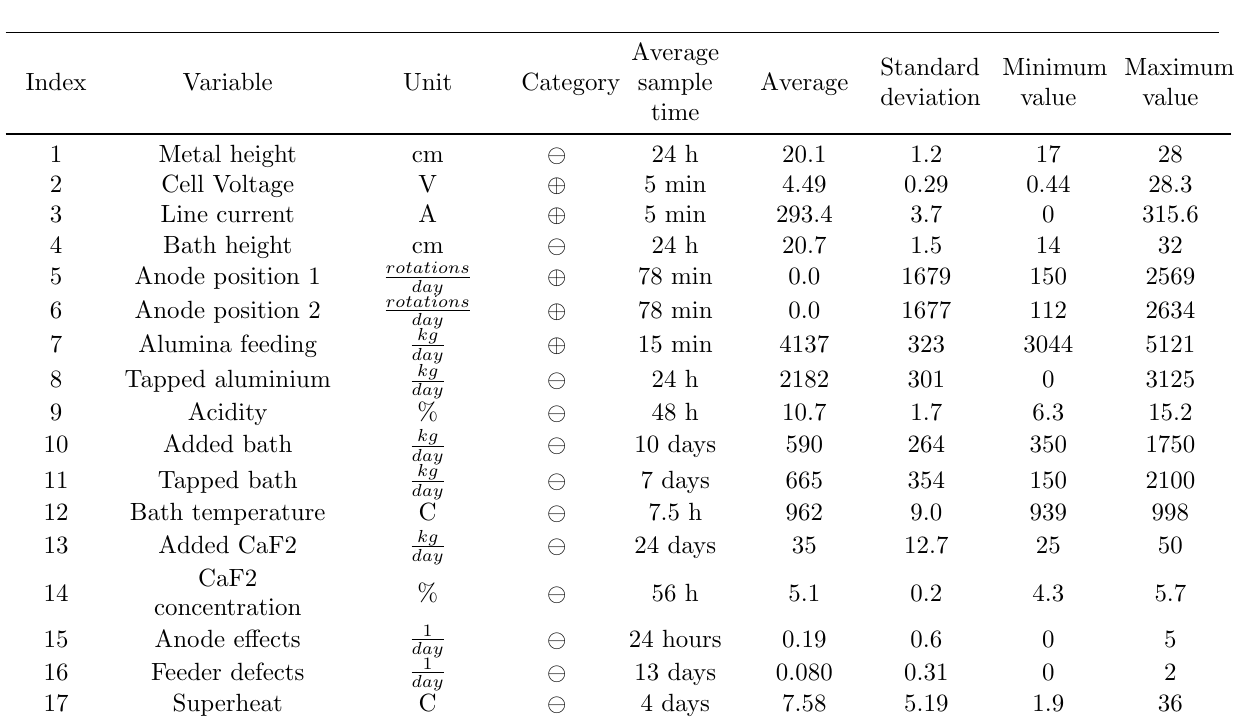
Table 3: Common measured variables in aluminium electrolysis plants. The statistics are based upon process data from one single aluminium electrolysis cell generated over one year. The measurements can be categorized into two main categories; on-line measurements ( ⊕ ) and measurements performed with manual interactions ( (cid:9)